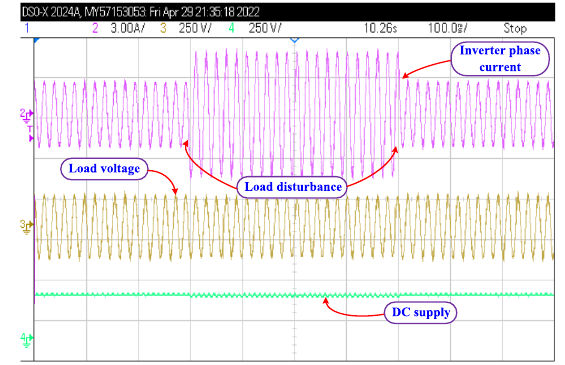
Fig. 29 Dynamic response of voltage and phase current of 3-phase VSI [phase current (Ch2); load voltage (Ch3); input DC voltage